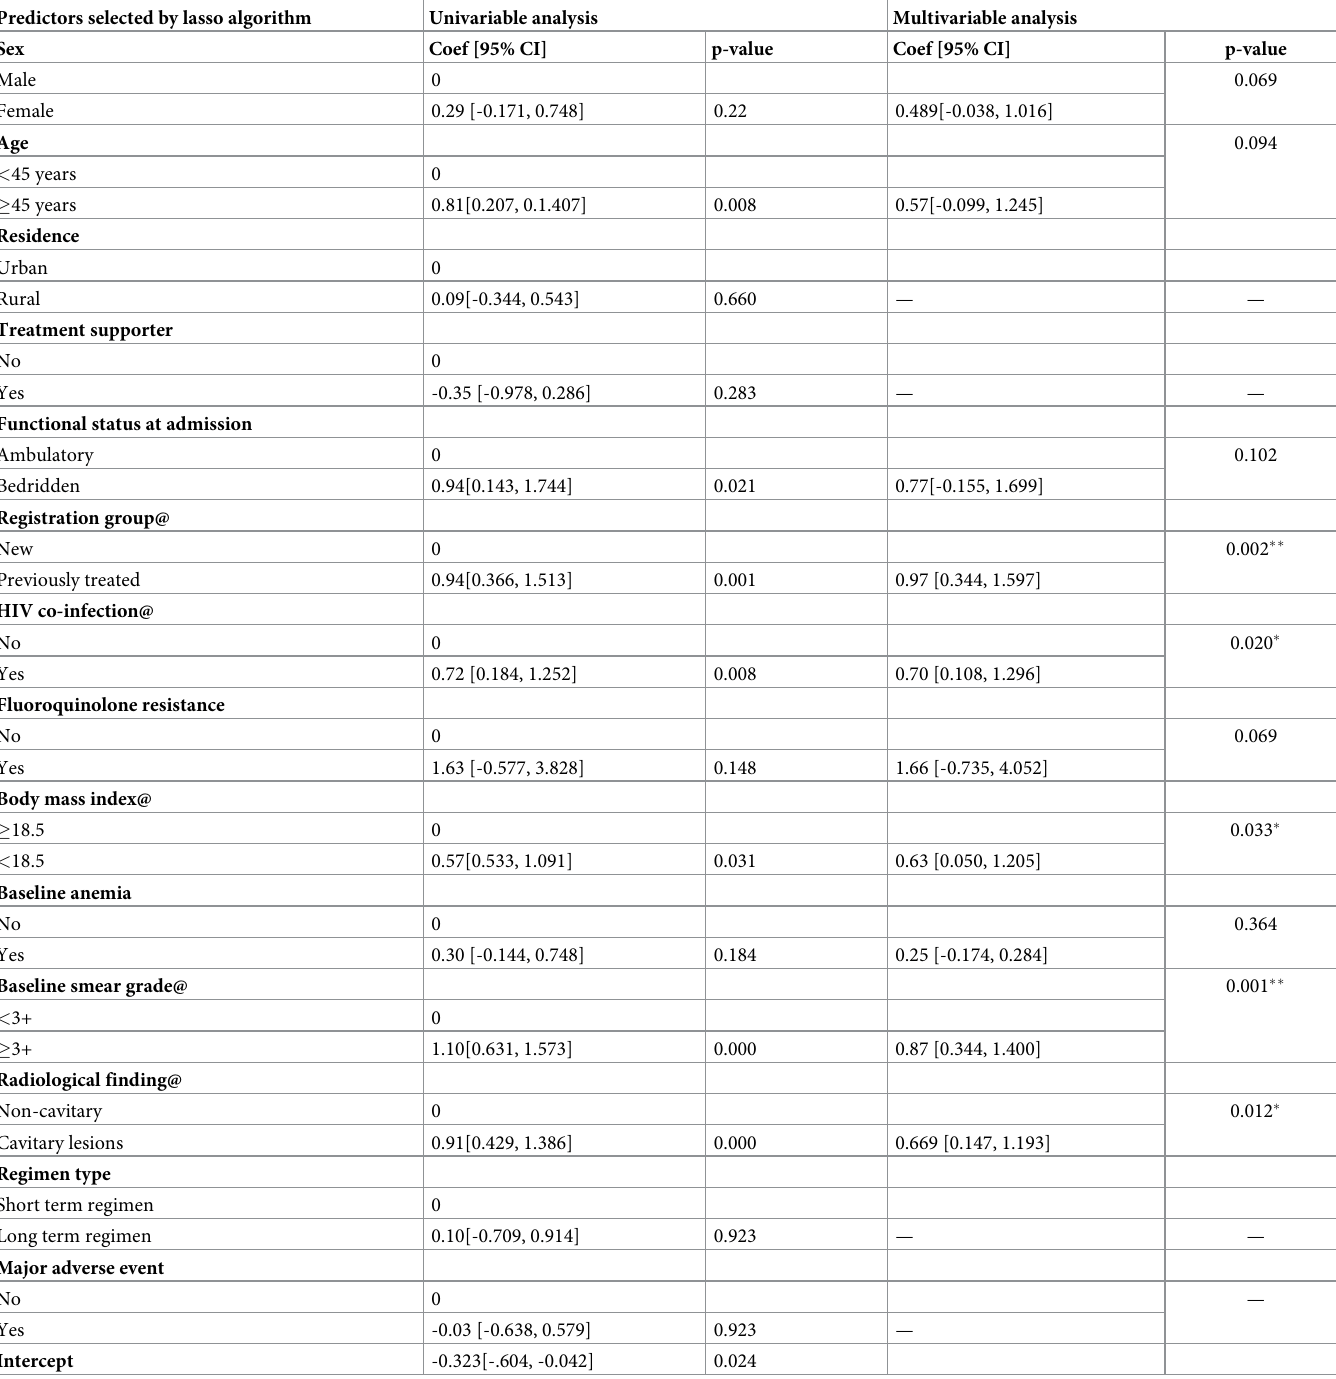
Table 3. Univariable and multivariable logistic regression analysis using potential predictors of late culture conversion in patients with multidrug-resistant tuber- culosis, in North West Ethiopia, 2010–2020 (N =